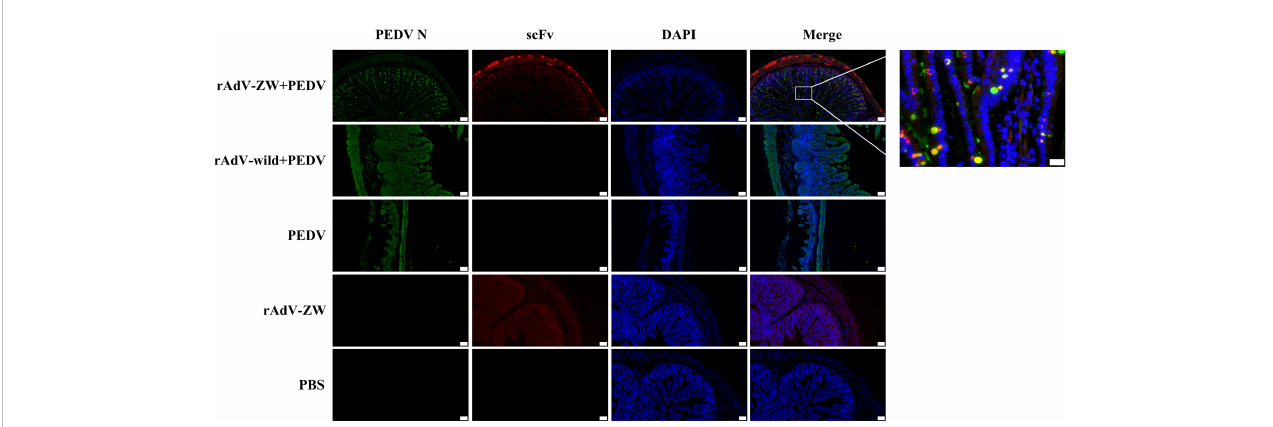
FIGURE 6 ScFv and PEDV N protein expression in jejunum by immuno fl uorescence. Jejunum samples were collected from piglets orally administrated rAdV-ZW after challenge with PEDV. Paraf fi n sections were stained with FITC, CY3, and DAPI and observed at 100× magni fi cation (left). Scale bar = 100 m m. (Right) (630×) Enlarged framed area in (left). Scale bar = 20 m m. Green represents the PEDV N protein; red represents scFvs, and blue indicates DAPI-stained nuclei. In merged images, orange indicates ZW co-localization (including ZW1-16, ZW3-21, ZW1-41, and ZW4-16) with the PEDV N